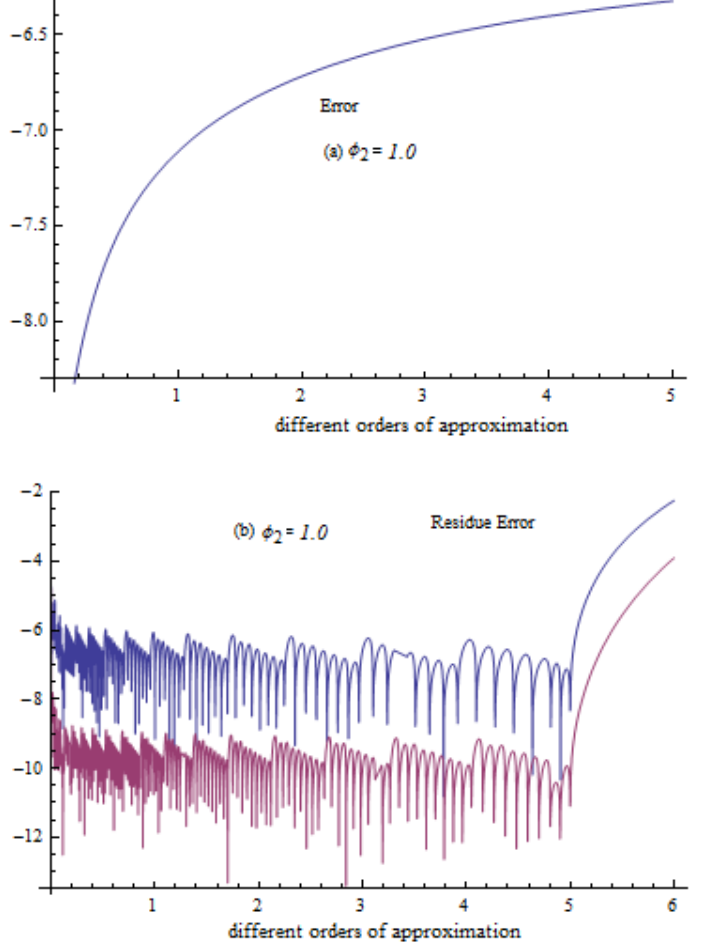
Figure 8. Error ( a ) and residue error ( b ) for φ 2 = 1.0. The blue line represents the average residue error and the red line represent the total average residue error in ( b ).